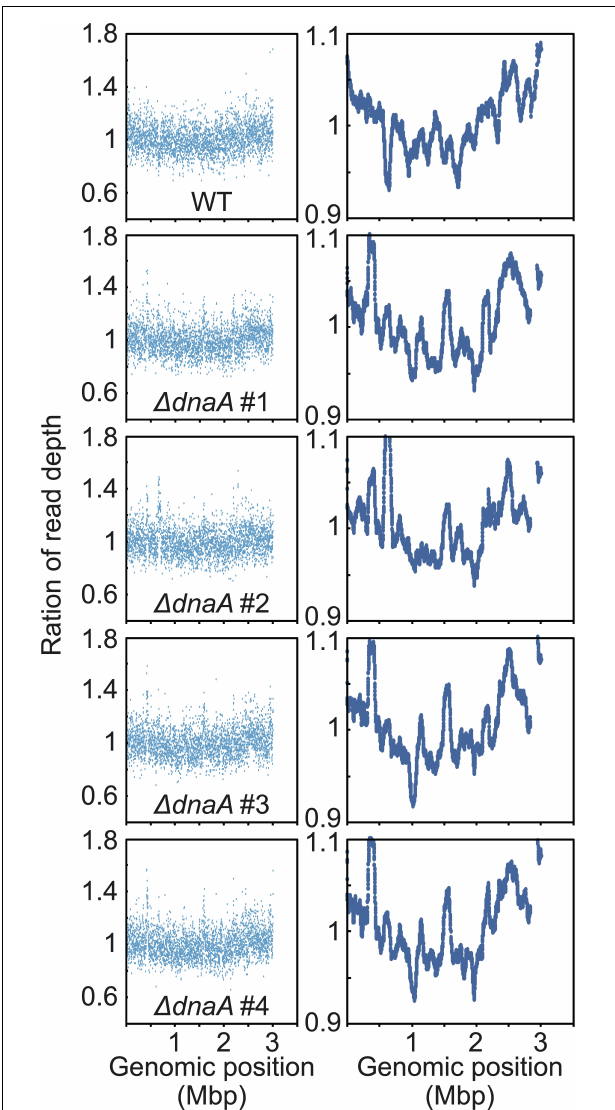
FIGURE 5 | Chromosomal replication origins of Synechococcus sp. PCC 7002 WT and dnaA disruptants. Depth of the high-throughput genomic DNA reads at respective chromosomal regions in exponentially growing WT and (cid:49) dnaA cells. Genomic DNA was extracted from cells 24 h after inoculation ( Figure 4B ) and analyzed using an Illumina MiSeq System. The number of reads (divided by the number of total reads) of the growing (replicating) cells was normalized by that of the stationary phase (non-replicating) cells at each genomic position. 1-kb window (left) and 100-kb window (right) of WT and (cid:49) dnaA clones.